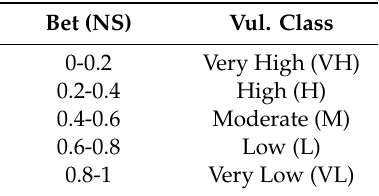
Table 3. The physical vulnerability classes based on Bet